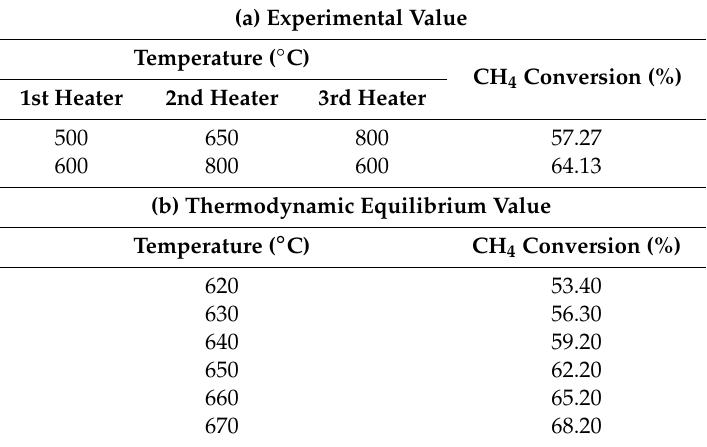
Table 2. Catalyst bed temperature gradient and CH 4 conversion under abnormal